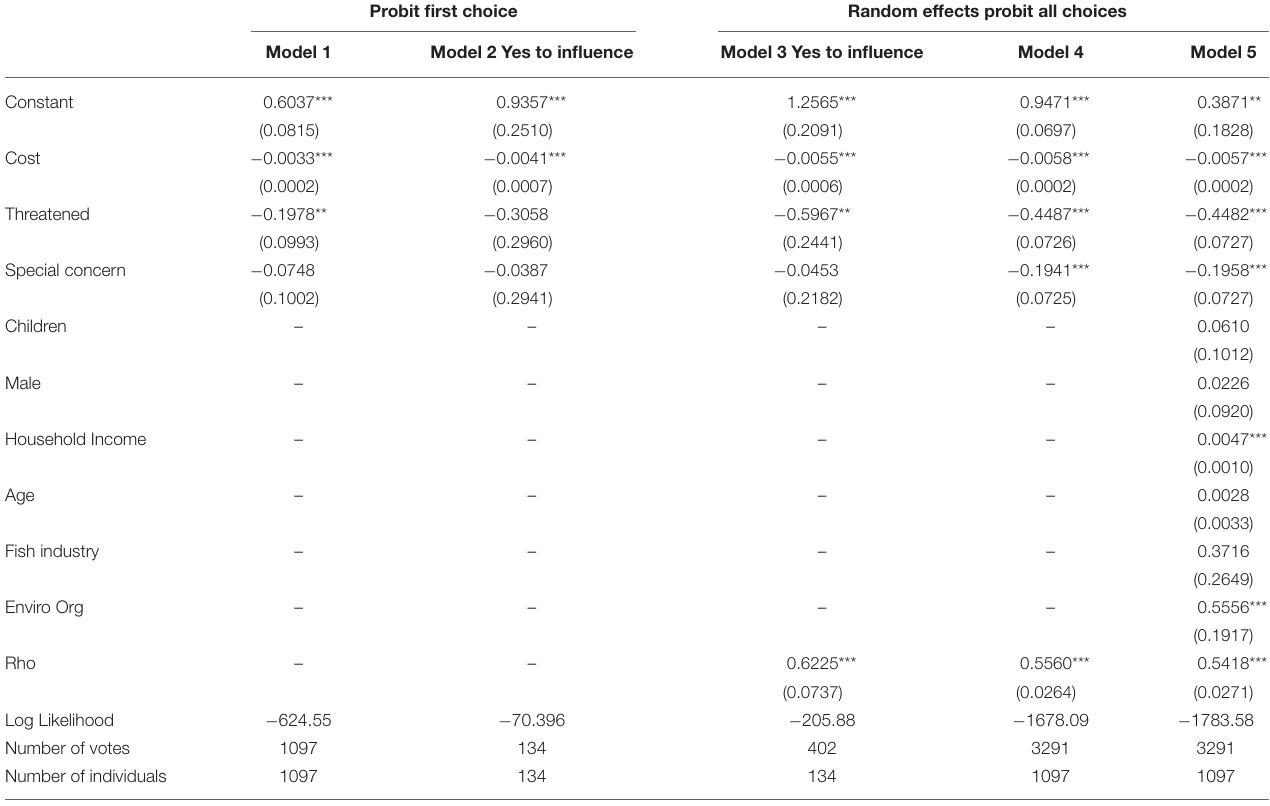
TABLE 3 | Estimates of probit regression